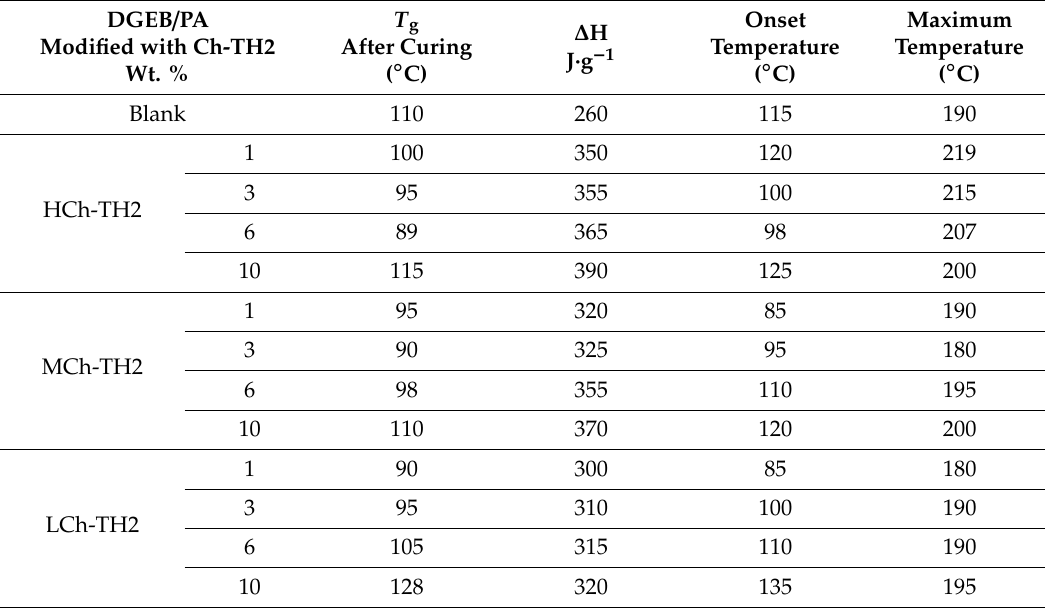
Figure 7. Non-isothermal DSC thermograms of the cured DGEB/PA in the presence of different Wt. % of ( a ) LCh-TH2, ( b ) MCh-TH2 and ( c ) HCh-TH2. Table 1. DSC data of DGEB/ polyamine (PA) at a heating rate of 5 °C·min − 1 in the absence and presence of different Wt. % of Ch-TH2.